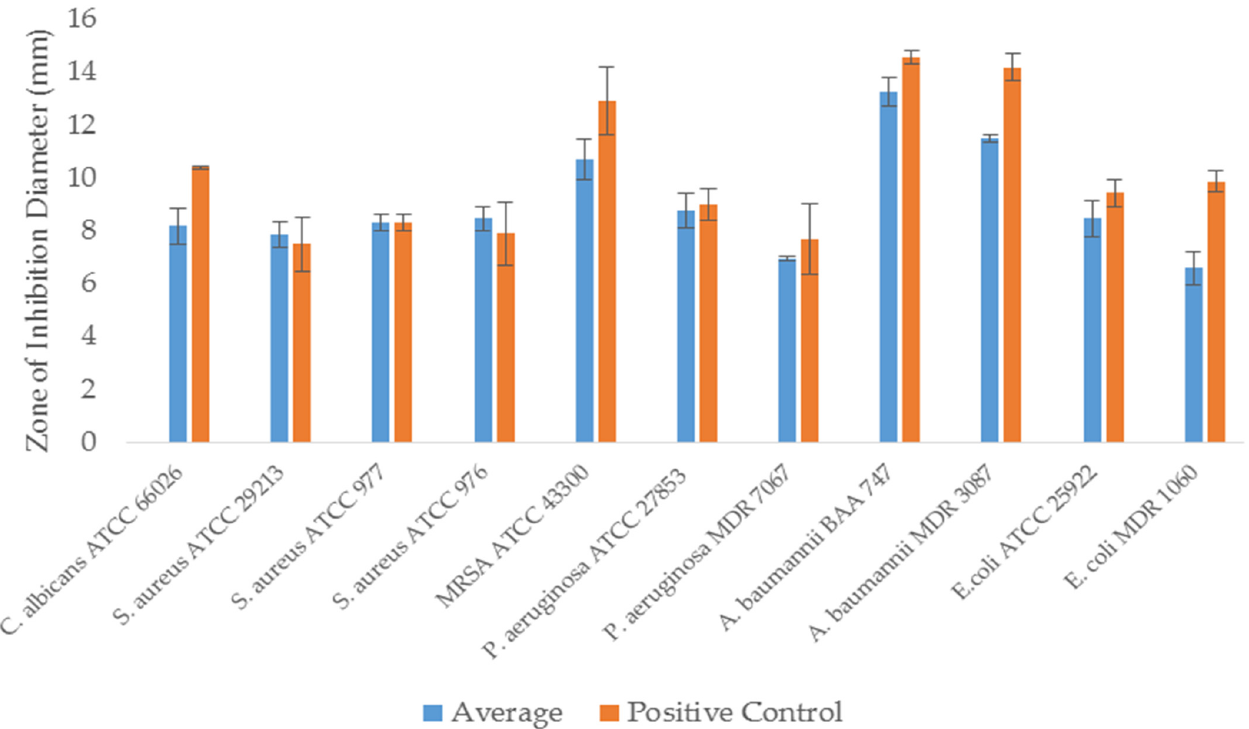
Figure 6. The zone of inhibition of melittin-loaded fibers against different antimicrobial-sensitive and -resistant bacterial strains, in addition to C. albicans yeast, compared to melittin containing discs (positive control). It shows that both melittin-loaded fibers and discs were effective against all strains when applied at equivalent amounts, suggesting that melittin retained its antimicrobial activity after electrospinning. The results are presented as average ± SD of independent triplicates.